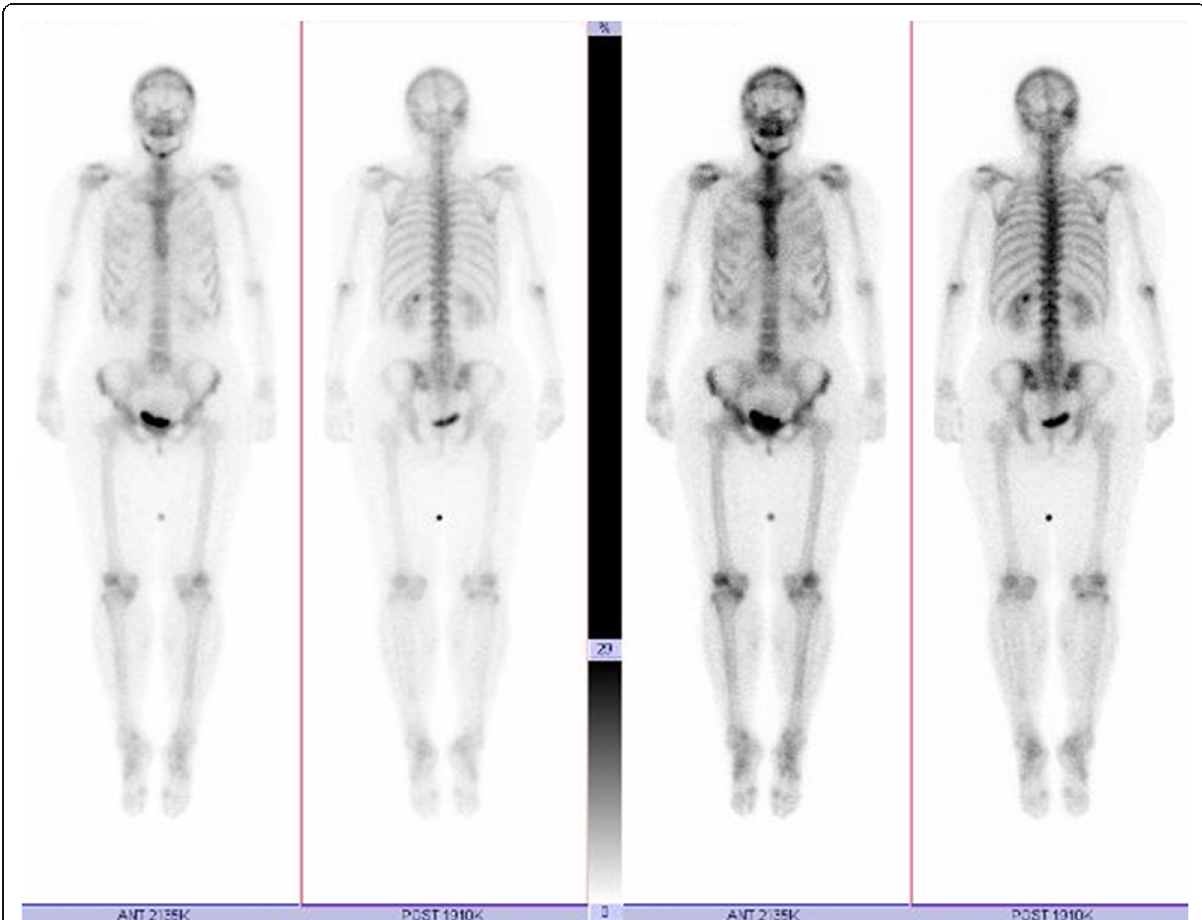
Fig. 4 99mTc bone scintigraphy shows tracer uptake in the maxillary and mandibular